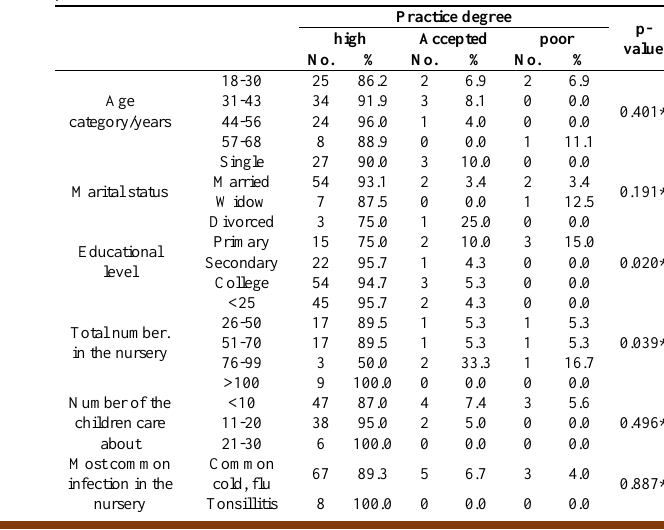
Table 4: Relationship of practice degree with